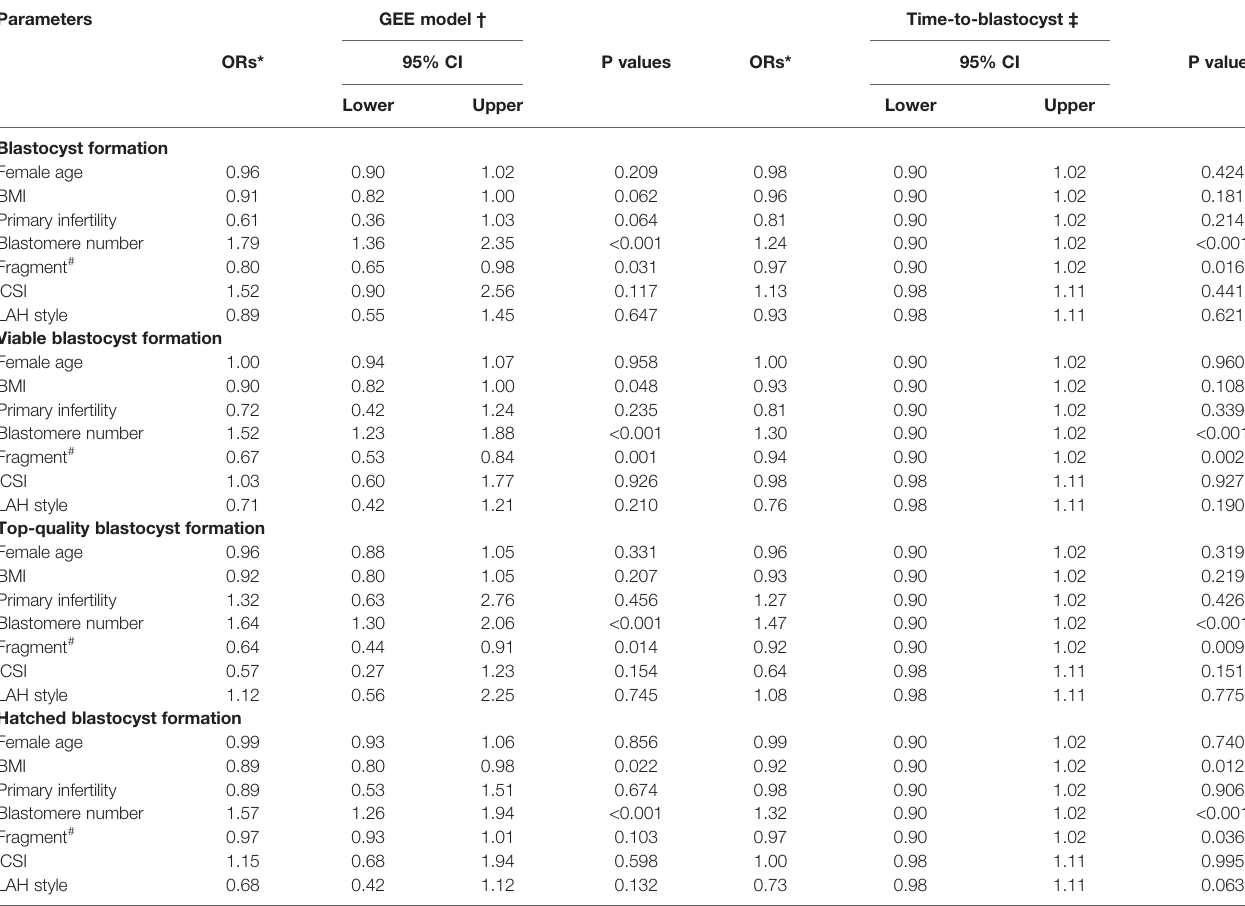
TABLE 3 | GEE analysis and time-to-blastocyst analysis on the blastocyte culture outcomes of fragmented day-3 embryos. Parameters GEE model †